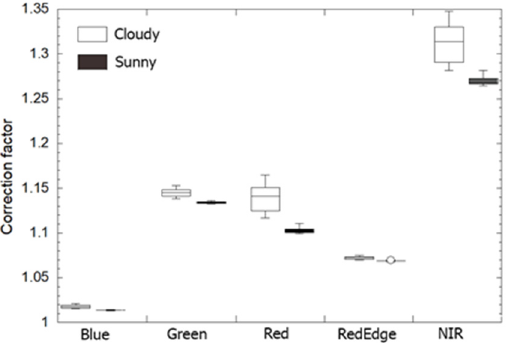
Figure 5. A boxplot of correction factors of the five RedEdge-M bands. All CRP calibration images in both field and drone experiments are used.